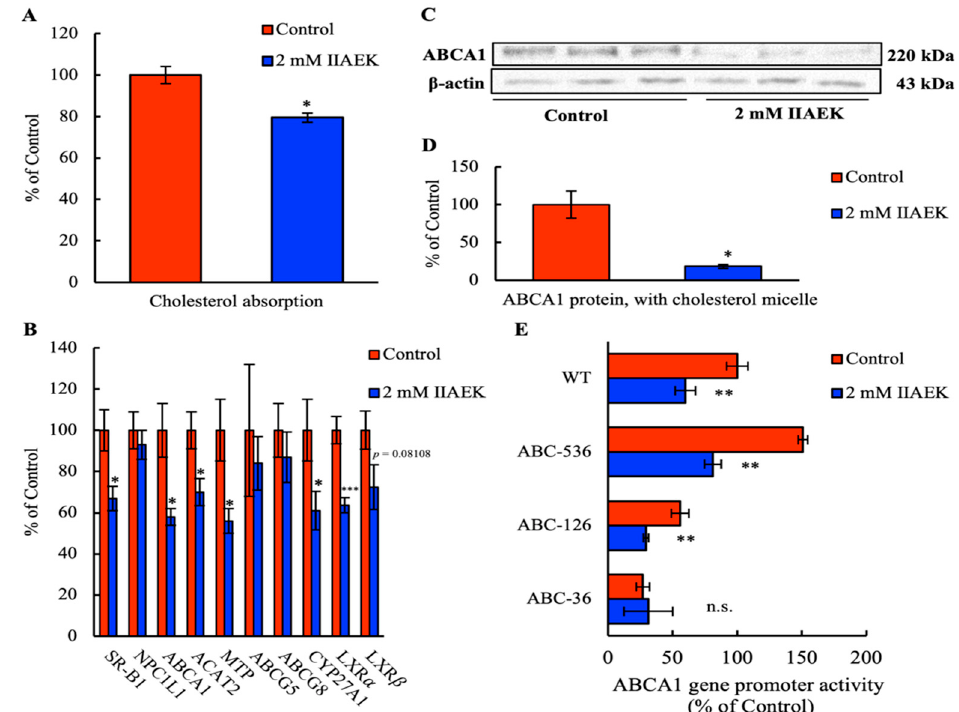
Figure 1. E ff ect of IIAEK (Ile-Ile-Ala-Glu-Lys, lactostatin) containing cholesterol micelle on cholesterol metabolism in Caco-2 cells. ( A ) E ff ect of IIAEK containing cholesterol micelle on cholesterol absorption rate in Caco-2 cells. ( B ) E ff ect of IIAEK containing cholesterol micelle on cholesterol metabolism-associated gene expression in Caco-2 cells. Values are represented as means ± standard errors, represented by vertical bars ( n = 6 per group). ( C ) E ff ect of IIAEK containing cholesterol micelle on ATP-binding cassette transporter A1 (ABCA1) protein level in Caco-2 cells by Western blot. ( D ) ABCA1 protein level was quantified with ImageJ and normalized to the level of β -actin. Values are represented as mean ± standard error, represented by vertical bars ( n = 3 per group). ( E ) E ff ect of IIAEK containing cholesterol micelle on ABCA1 gene promoter activity in Caco-2 cells. Caco-2 cells were transfected with the human pGL3-ABCA1-Luc plasmid (WT: − 928 to + 107 bp) or the pGK3-ABCA1-Luc plasmid deletion mutants (ABC–536: − 536 to + 107 bp, ABC–126: − 126 to + 107 bp, ABC–36: − 36 to + 107 bp), using the pPGK β -galactosidase plasmid as an internal control. Data are presented as luciferase activity normalized to β -galactosidase activity. Values are represented as means ± standard error, represented by vertical bars ( n = 5–9 per group). Asterisks indicate the di ff erence from the control (* p < 0.05, ** p < 0.01, *** p < 0.001), as determined by Student’s t -test.